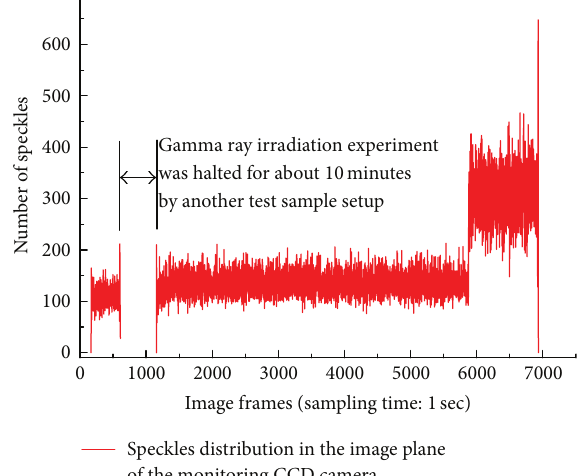
Figure 9: Speckles distribution of the CCD monitoring camera